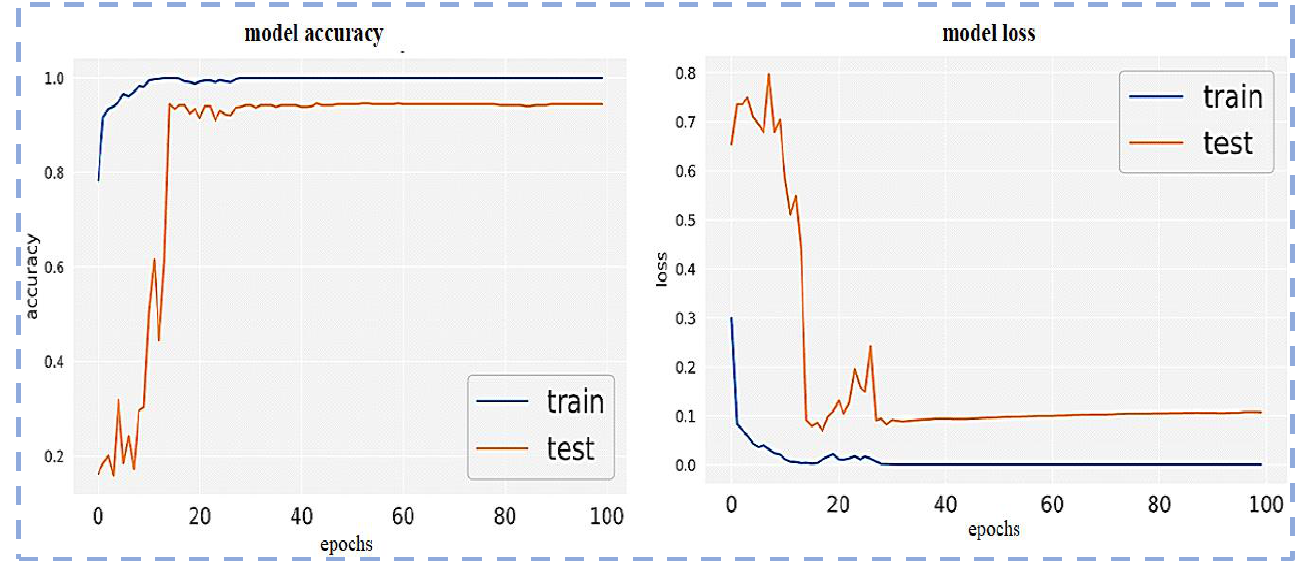
Figure 12. Model loss and model accuracy using Inception-v3.